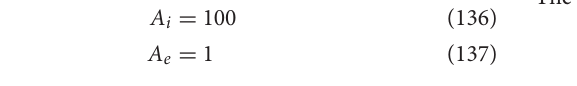
20 /ω p e solved using the domain-hybridized plasma model. The left and right subdomains =